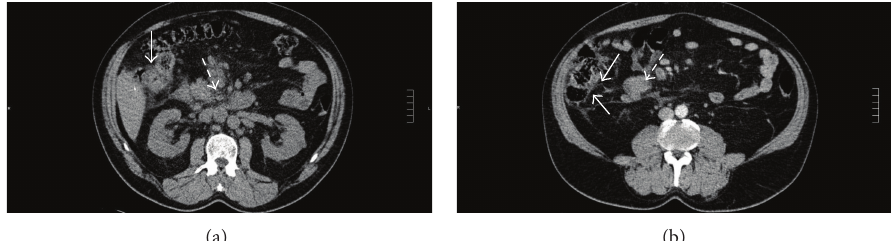
Figure 3: (a) Abdominal computed tomography. Circumferential thickening of the ascending colon wall (full arrow), multiple mesenteric lymphadenopathy, and thickening of the mesenteric fat (dashed arrow). (b) Abdominal computed tomography. Stranding of the pericolic fat of the ascending colon (full arrows) and lymphadenopathy conglomerate adjacent to the right anterior pararenal fascia (dashed arrow).